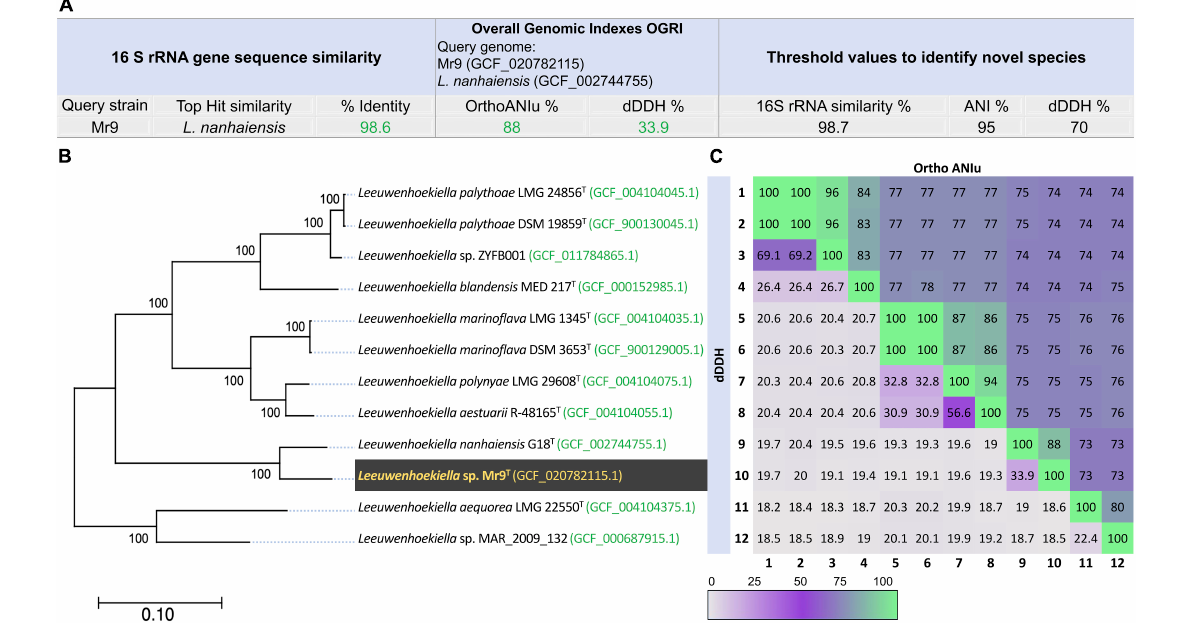
FIGURE1 (A) 16S rRNA gene sequences similarity and overall genome relatedness index (OGRI) values among strain Mr9 T and Leeuwenhoekiella nanhaiensis G18 T . (B) Approximately maximum-likelihood phylogenomic tree based on the alignment of 2,103 translated single-copy core genes, showing the relationship among strain Leeuwenhoekiella sp. Mr9 T and the members of the genus Leeuwenhoekiella. The genome sequence accession numbers are shown in parentheses. Bootstrap percentages are shown above the branches. Bar, 0.10 substitutions per nucleotide position. (C) Heatmap plot of genome-to-genome analysis by OrthoANIu (upper triangle) and dDDH (lower triangle) showing the percentage of similarity among the genus under study. The colors are displayed according to the color key, with a 100% value when converging in the matrix with the same